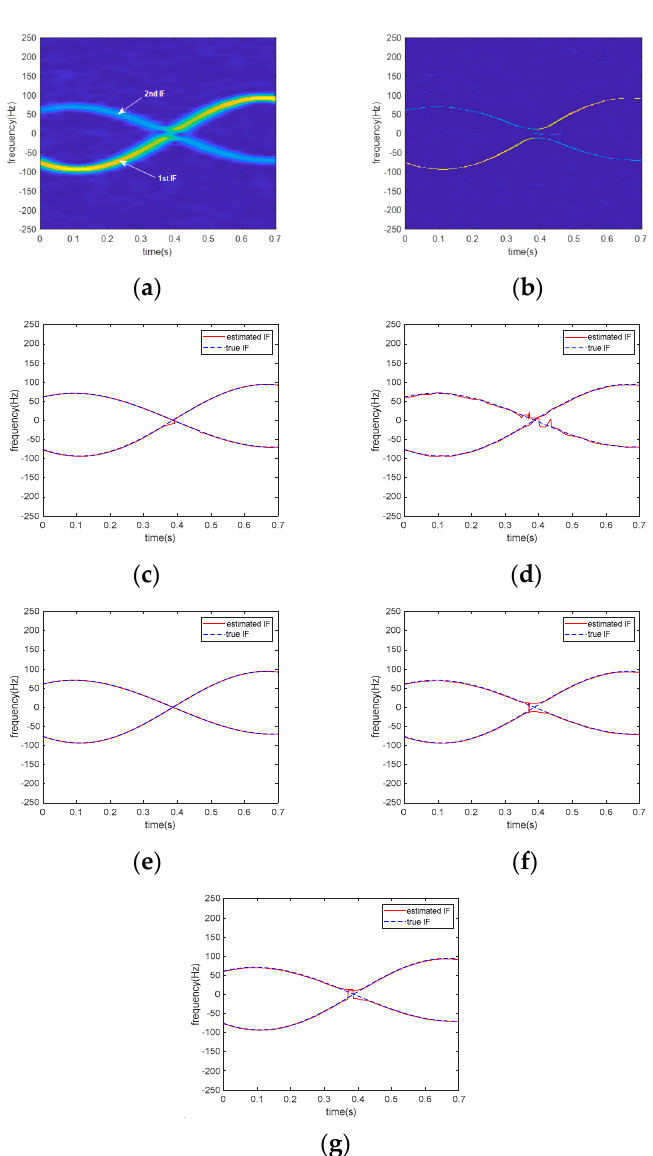
Figure 8. TF spectrums and IF estimation results for example 3 with SNR = 20 dB. ( a ) TF spectrum acquired by STFT; ( b ) TF spectrum acquired by SET. ( c ) MKF; ( d ) MTT; ( e ) CSRDI-MGPTF; ( f ) MD-STFT; ( g ) MD-SET.